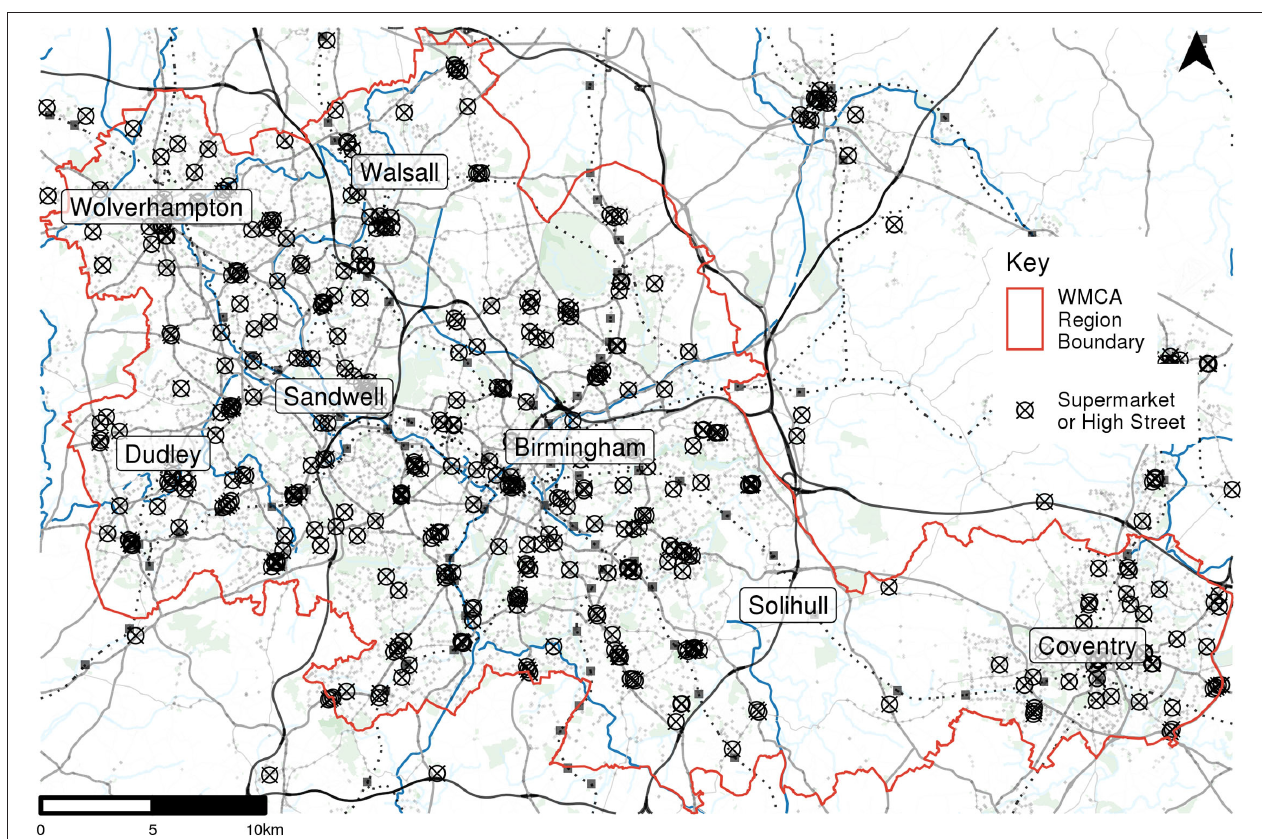
FIGURE 2 | High street and supermarket centroid